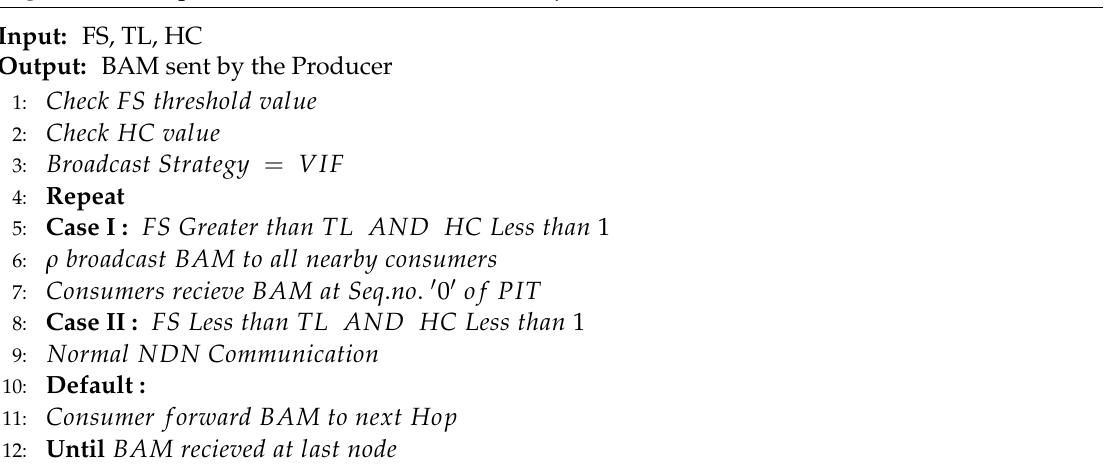
Algorithm 1 Proposed NDN Module for Producer ρ